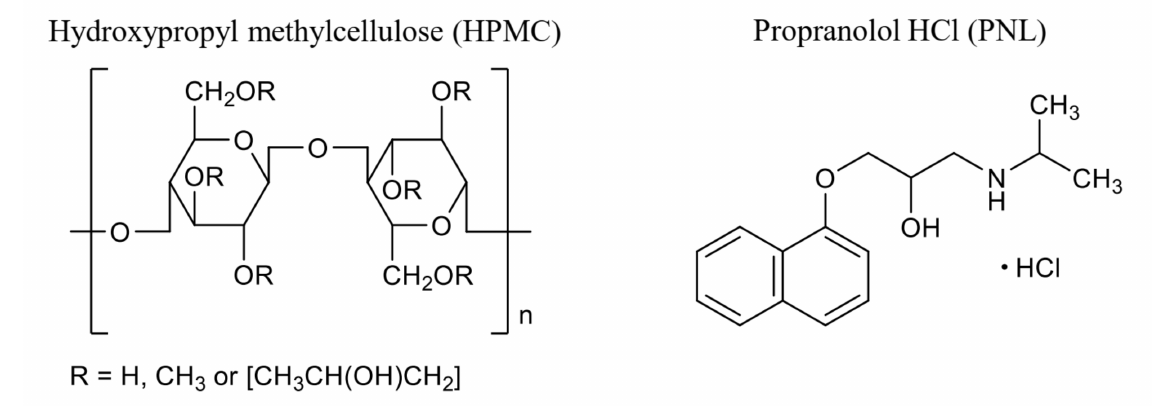
Figure 1. The chemical structures of HPMC and PNL.